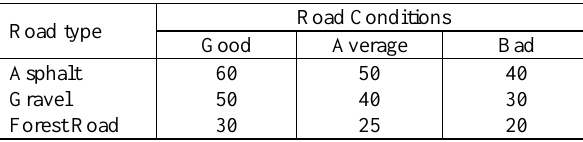
Table 2. The average travel speed of fire trucks (km/hour)